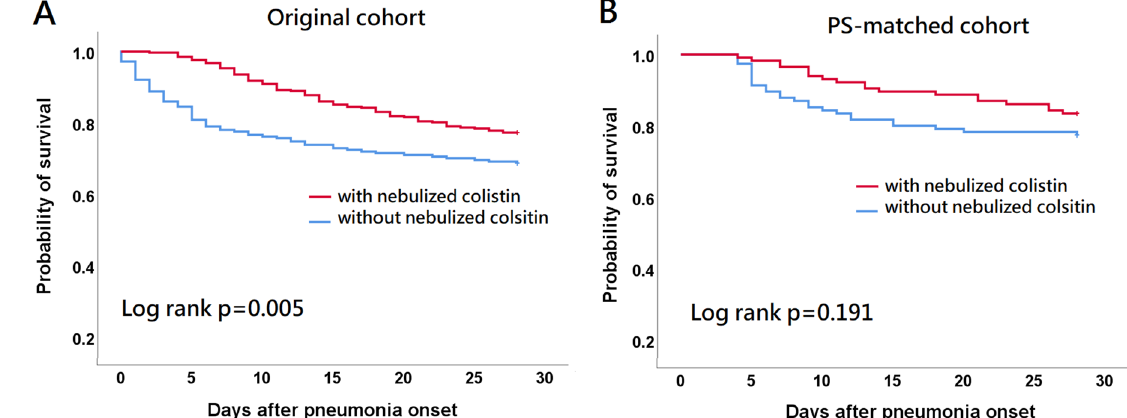
Fig. 2 Kaplan–Meier analysis of 28‑day mortality status. 28‑day mortality between patients with and without substitutive nebulized colistin in ( A ) original and ( B ) propensity score‑matched cohorts is